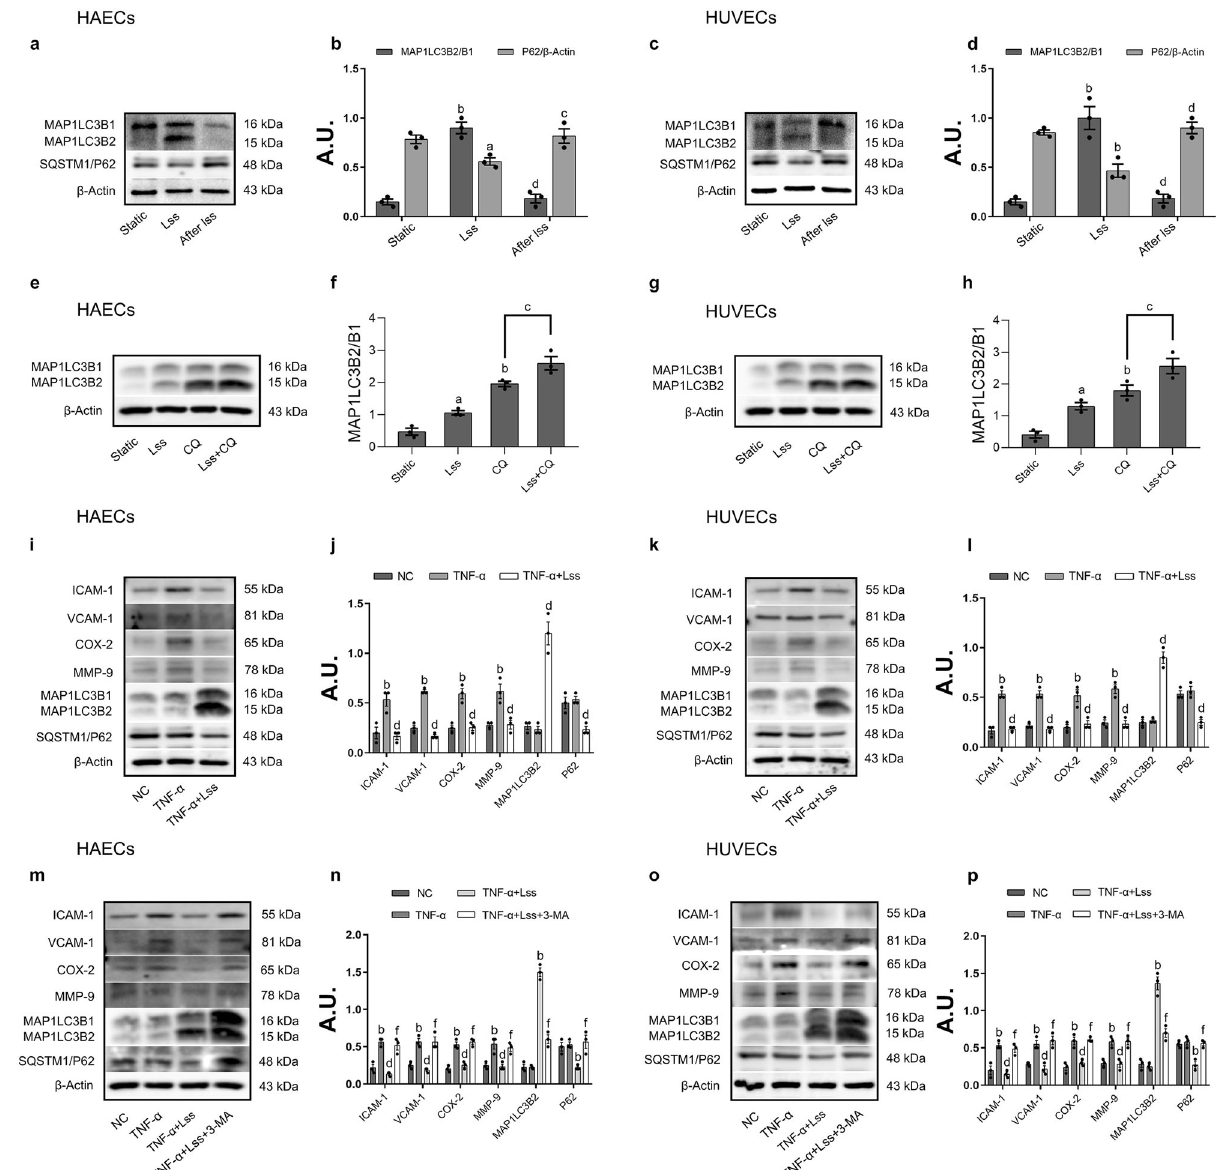
Fig. 1 LSS inhibits the in fl ammatory response in endothelial cells by activating autophagy. a , c Western Blot shows the expression of MAP1LC3B2 and SQSTM1/P62 in HAECs and HUVECs. b , d Relative expression of MAP1LC3B2 and SQSTM1/P62 in HAECs and HUVECs. Cells were treated with 12 dyn/ cm 2 LSS for 12 h, CQ (50 μ M) precedes LSS for 6 h, and e , g Western Blot shows the expression of MAP1LC3B2 in HAECs and HUVECs. f , h Relative expression of MAP1LC3B2 in HAECs and HUVECs. Cells were stimulated with TNF- α (10 ng/ml) for 12 h and then treated with LSS for another 12 h, and i , k Western Blot shows the expression of ICAM-1, VCAM-1, COX-2, MMP-9, MAP1LC3B2, and SQSTM1/P62 in HAECs and HUVECs. j , l Relative expression of ICAM-1, VCAM-1, COX-2, MMP-9, MAP1LC3B2, and SQSTM1/P62 in HAECs and HUVECs. Cells were pretreated with TNF- α (10 ng/ml) for 12 h and in the presence or absence of 3-MA (5 mM) for another 2 h, followed by LSS treatment for another 12 h, and m , o Western Blot shows the expression of ICAM-1, VCAM-1, COX-2, MMP-9, MAP1LC3B2, and SQSTM1/P62 in HAECs and HUVECs. n , p . Relative expression of ICAM-1, VCAM-1, COX-2, MMP-9, MAP1LC3B2, and SQSTM1/P62 in HAECs and HUVECs. Data are presented as mean ± SEM of three independent experiments. a P < 0.05, b P < 0.01 vs. Static or NC group; c P < 0.05, d P < 0.01 vs. LSS or TNF- α or CQ group; e P < 0.05, f P < 0.01 vs. TNF- α + LSS group. AU arbitrary